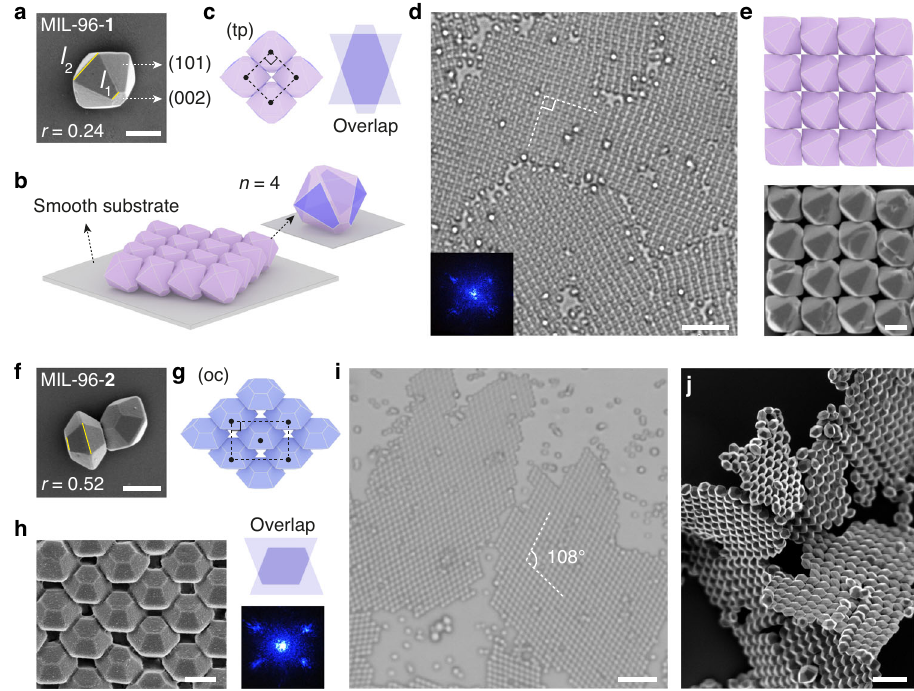
Fig. 5 Truncation-dependent assembly of MIL-96 2D fi lms. a – e Square (tp) lattice formed by MIL-96- 1 . SEM image ( a ) of MIL-96- 1 with small truncation ( r = l 1 / l 2 = 0.24); the (101) and (002) facets are labeled. Cartoon in b shows each MIL-96- 1 particle adheres to the substrate by (101) facet and packs with four neighboring particles by contacting their trapezoidal faces (purple) ( n = 4). Cartoons in c show the unit cell and the antiparallel face overlap. Optical microscope image ( d ), laser diffraction pattern ( d , inset), cartoon and SEM image ( e ) show the square lattices assembled from MIL-96- 1 . f – j Centered rectangular (oc) lattice formed by MIL-96- 2 . SEM image of MIL-96- 2 ( r = 0.52) is shown in f . Cartoons ( g ), SEM ( h ), and optical microscope image ( i ) show the structure of MIL-96- 2 superlattice (axial angle = 108°). The unit cell is labeled in g . The face overlap and laser diffraction pattern are shown in ( h ). SEM image in j shows the pieces of MIL-96- 2 fi lms. Scale bars: 0.5 μ m ( a , e , f , h ), 5 μ m ( d , i ), and 2 μ m ( j